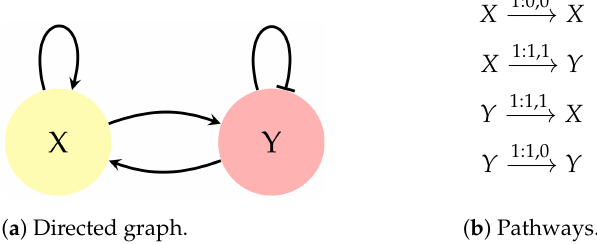
Figure 1. Example of genetic circuit with two genes X and Y . ( a ) Directed graph. Each node represents an agent in the circuit. These agents are often genes although they can also be inputs or metabolites. The edges convey relationships among nodes. The arrows indicate activation dependencies and the plain-ended links represent inhibition connections. ( b ) Set of